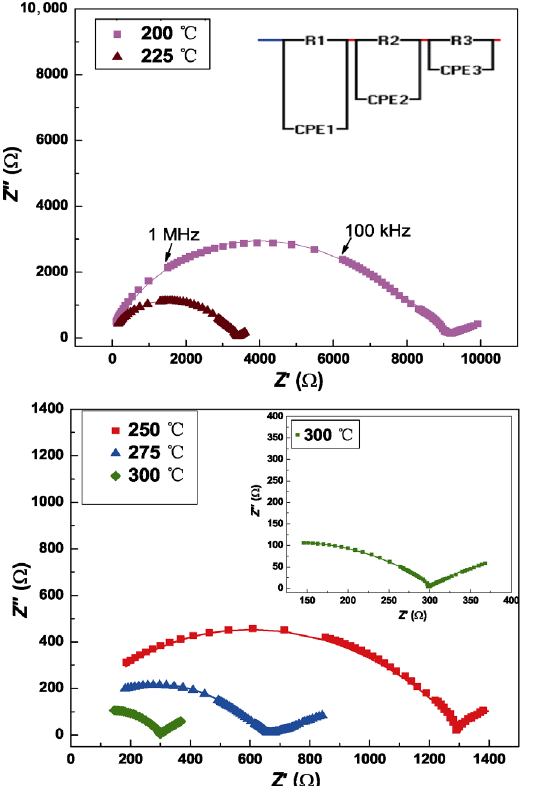
Fig. 7 Complex impedance plane plots of x = 0.175 at 200–300 ℃ . Note: The solid line shows the fitted